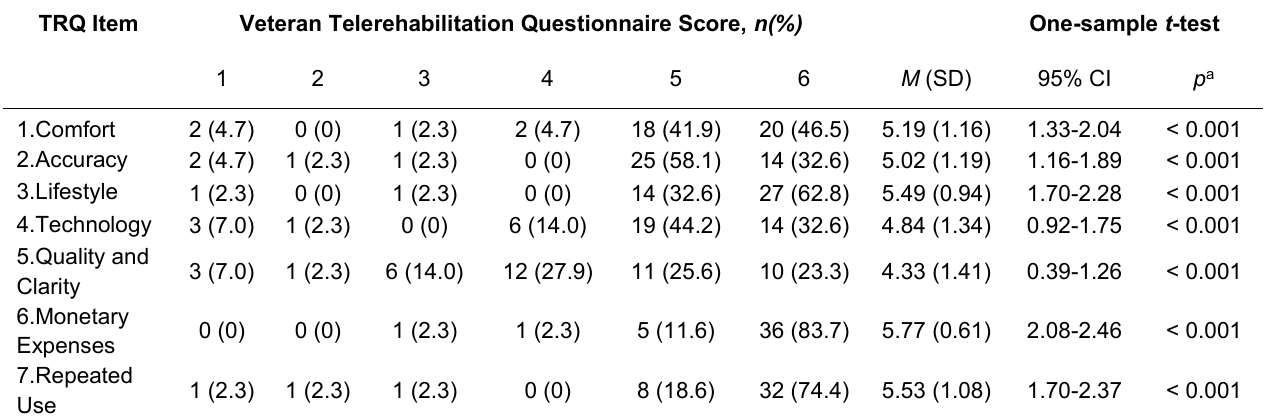
Provider Satisfaction with Telerehabilitation